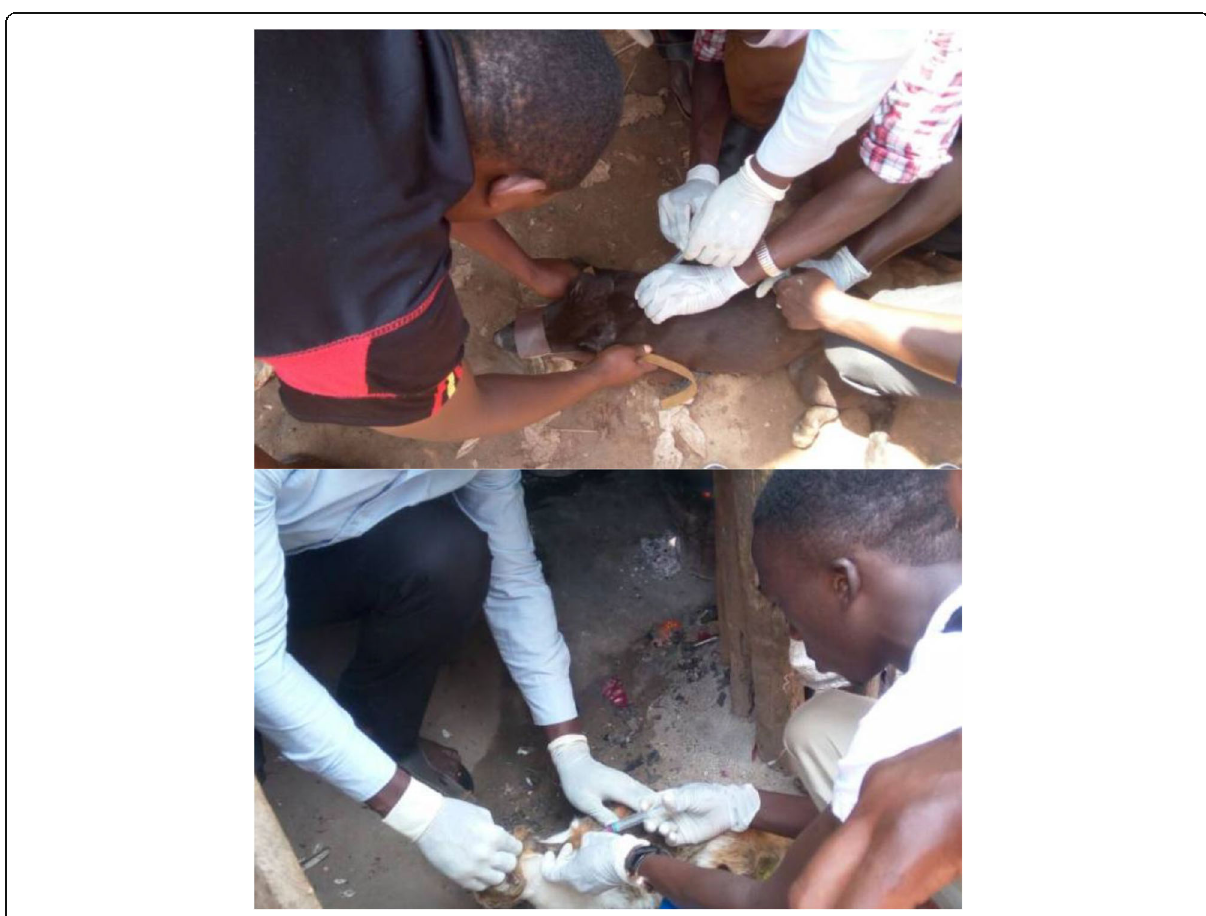
Fig. 1 Students One Health Innovation Club members during a vaccination campaign in some areas of Kampala city, 2017 that won a global competition in One